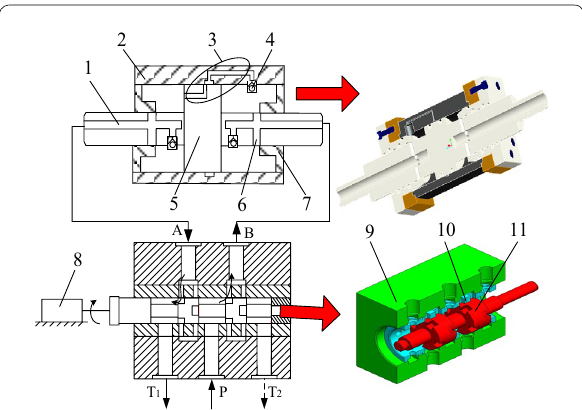
Figure 18 New type of electro-hydraulic vibration equipment for tamping device. 1. Main oil circuit; 2. Cylinder body; 3. Internal drainage passage; 4. Check valve; 5. Piston assembly; 6. Limit hole; 7. End cover; 8. Step motor; 9. Valve body; 10. Valve sleeve; 11. Spool; P: Oil supply port; T 1 : First oil return port; T 2 : Second oil return port; A, B: Load